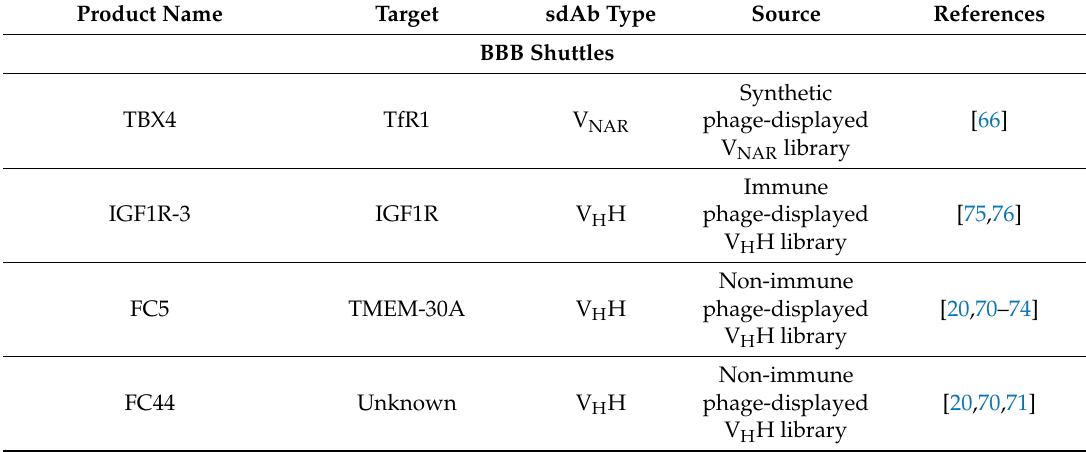
Table 1. Overview of single-domain antibodies developed for central nervous system